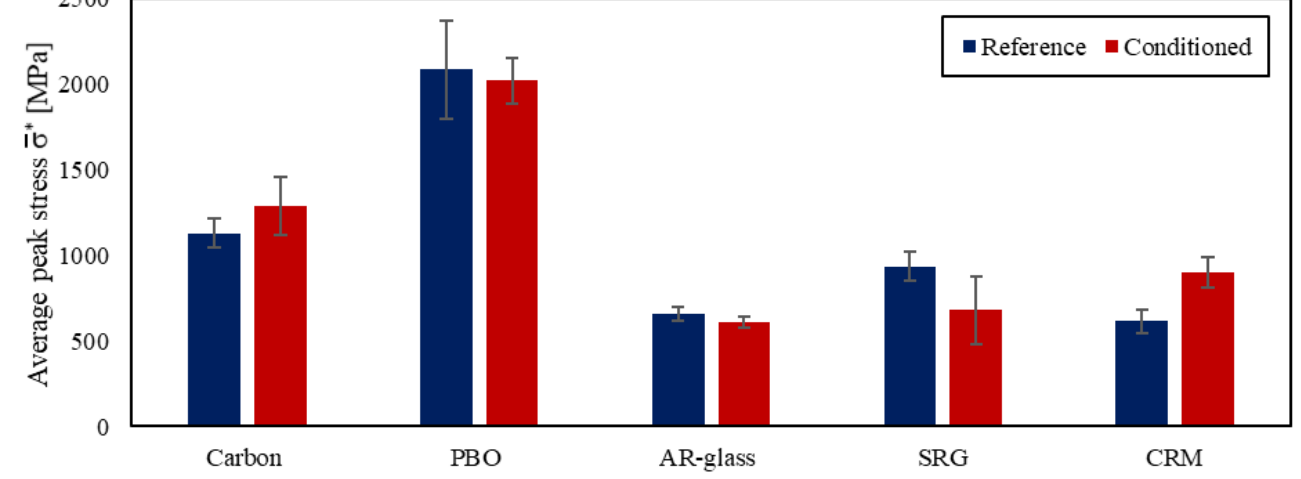
Figure 7. Comparison of average peak stresses of reference and conditioned specimens.